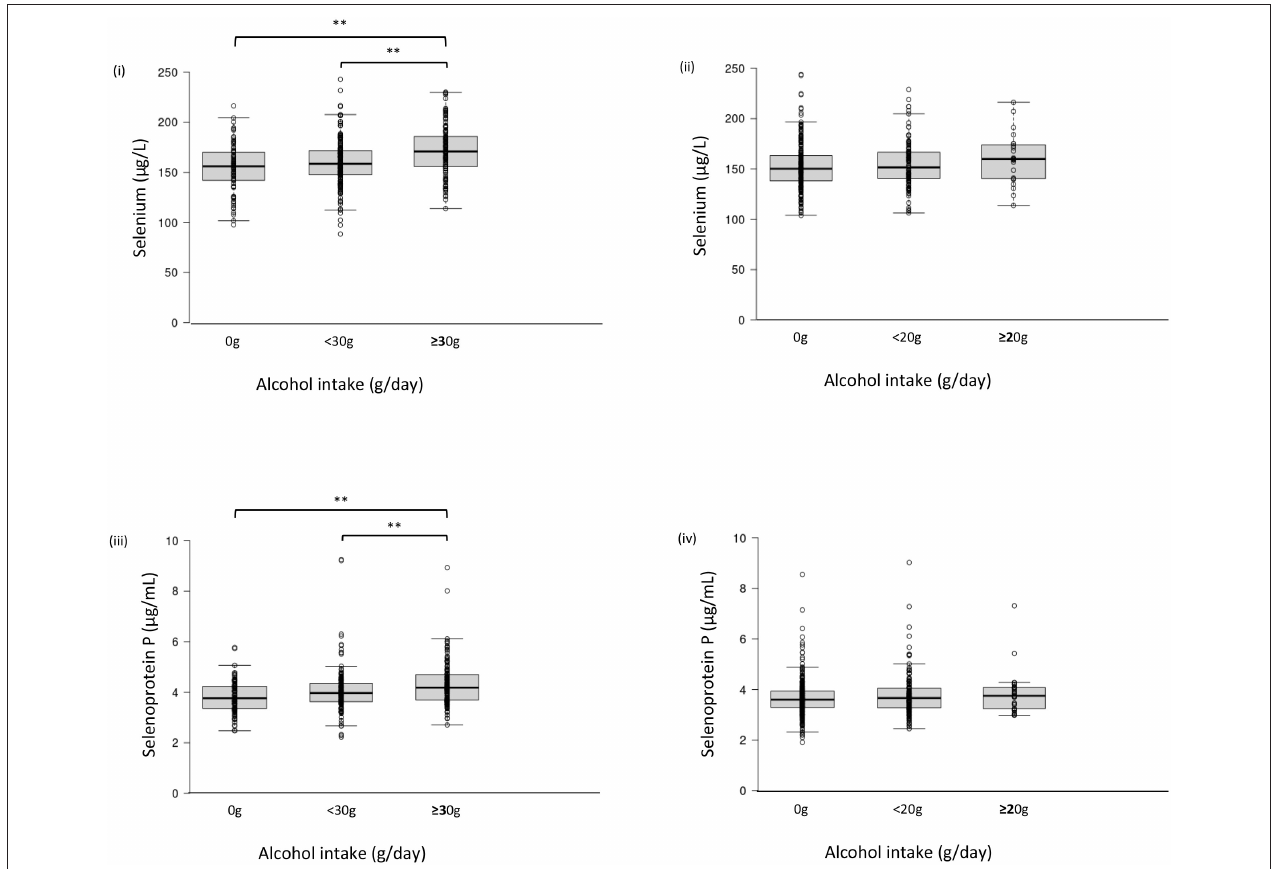
FIGURE 1 | Serum selenium/selenoprotein P levels in each group of alcohol intake. Serum level of selenium (i, ii) and selenoprotein P (iii, iv) in men (i, iii) and women (ii, iv). In box-plots, center lines show the medians, and box limits indicate the 25th and 75th percentiles; whiskers extend 1.5x the interquartile range from the 25th and 75th percentiles; data points are plotted as dots. ** p <